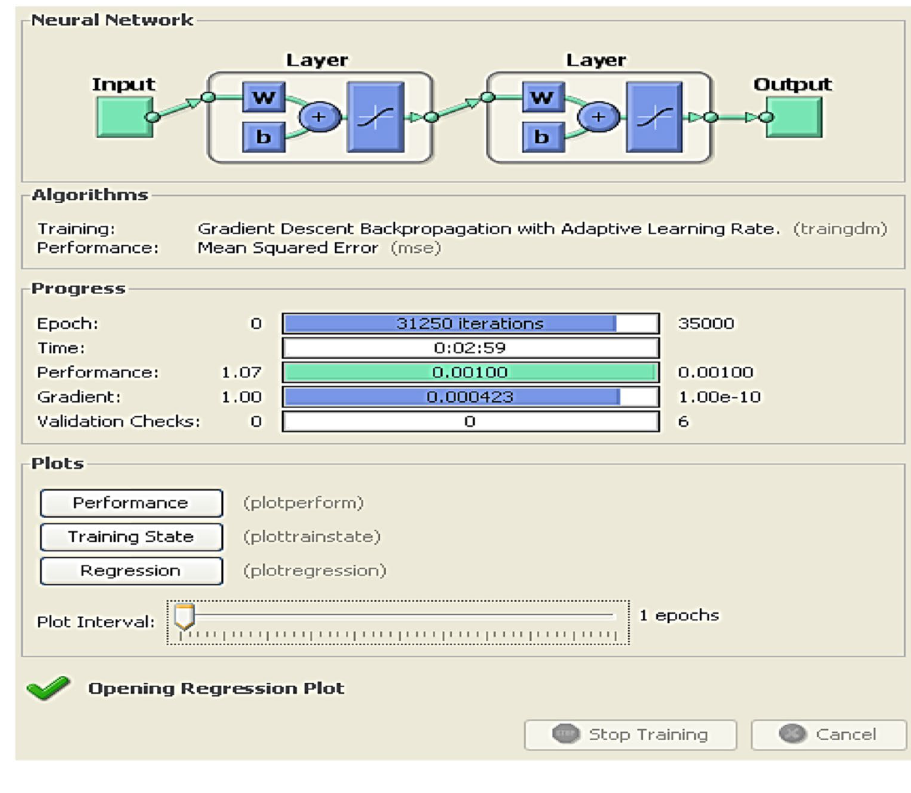
Fig. 4 Training in neural